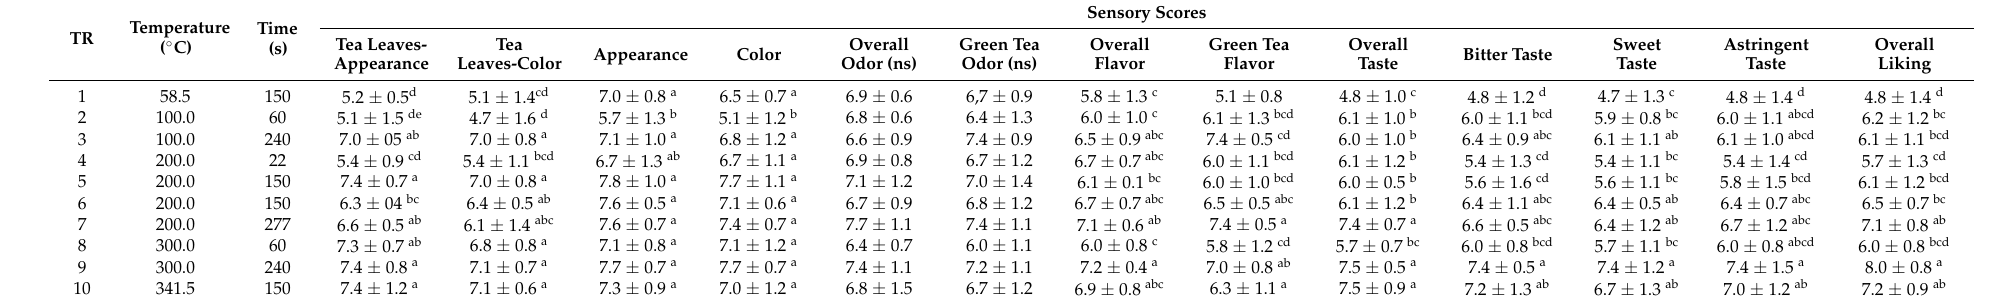
Table 3. Hedonic score of sensory attributes of green tea leaves from 10 different roasting temperatures and times of production z